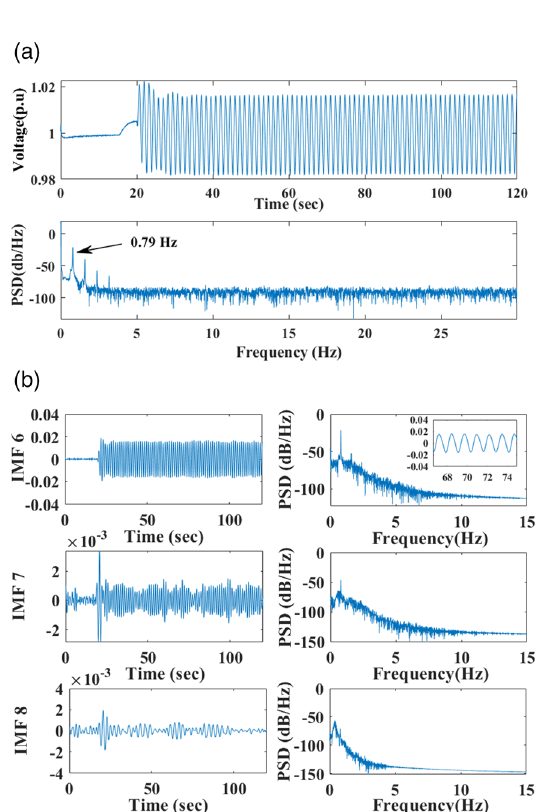
Fig. 4 a Simulated raw PMU signal and its PSD at bus 7. b Decomposed modes of the raw PMU